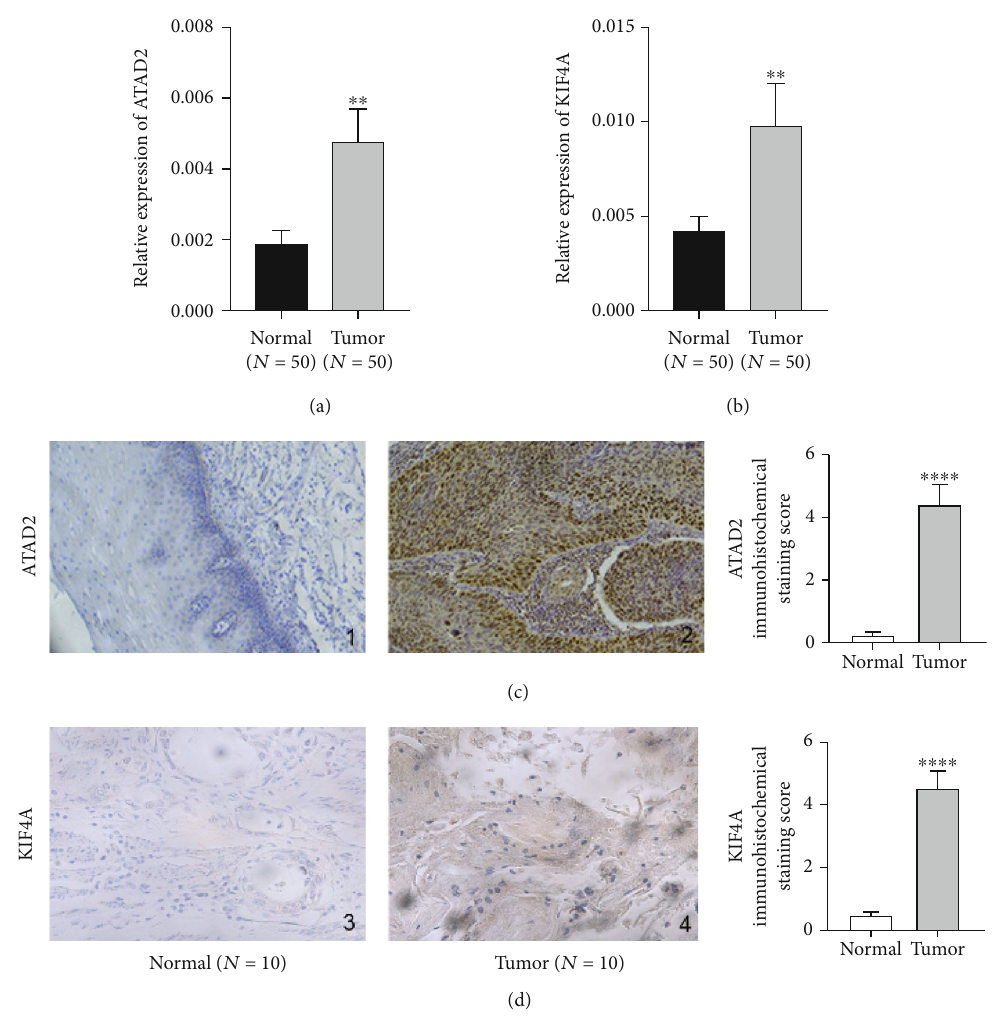
Figure 1: ATAD2 and KIF4A are highly expressed in ESCC. (a) ATAD2 in normal esophageal squamous epithelium and ESCC tissues was measured by RT-qPCR. (b) Highly expressed KIF4A in esophageal squamous epithelium and ESCC was measured by RT-qPCR. (c) Immunohistochemical results showed that ATAD2 protein was highly expressed in cancer tissues. (d) A highly level of KIF4A protein expression in ESCC tissues was revealed by immunohistochemical results. ∗∗ P < 0 : 01